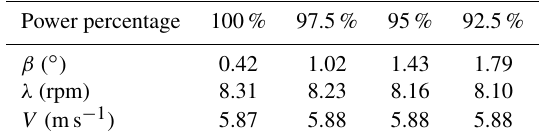
Table 3. Experimental conditions of the power-derating cases. Power